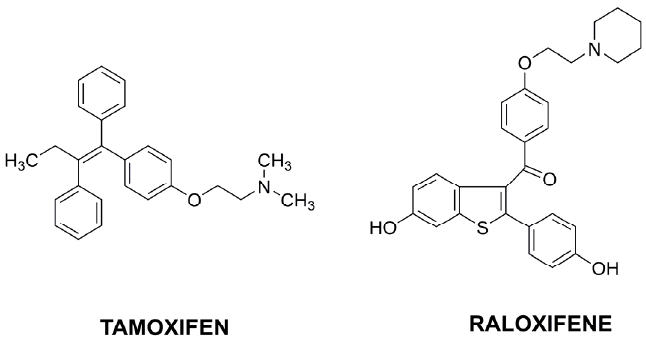
Figure 9. The selected structures of anticancer drugs affecting the hormonal environment.